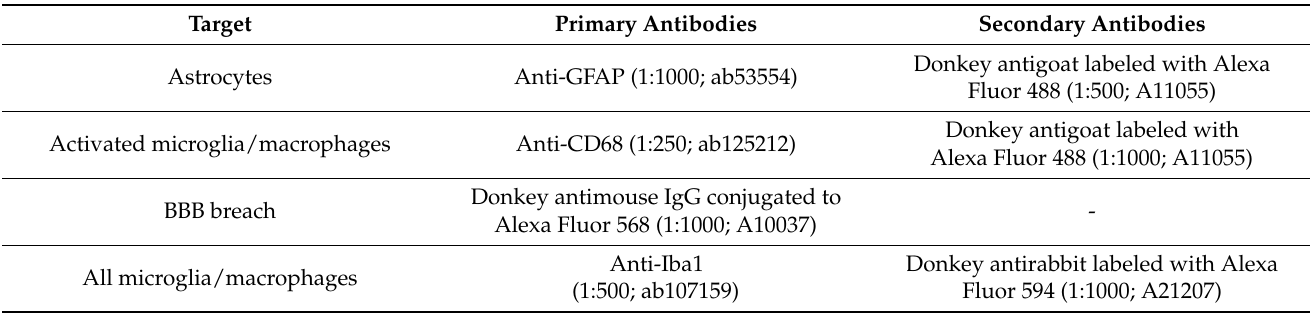
Alexa Fluor 594 1:1000 (Thermo Fisher Scientific, A21207) were used. The combination of antibodies is summarized in Table 3. Table 3. The combination of primary and secondary antibodies used in this